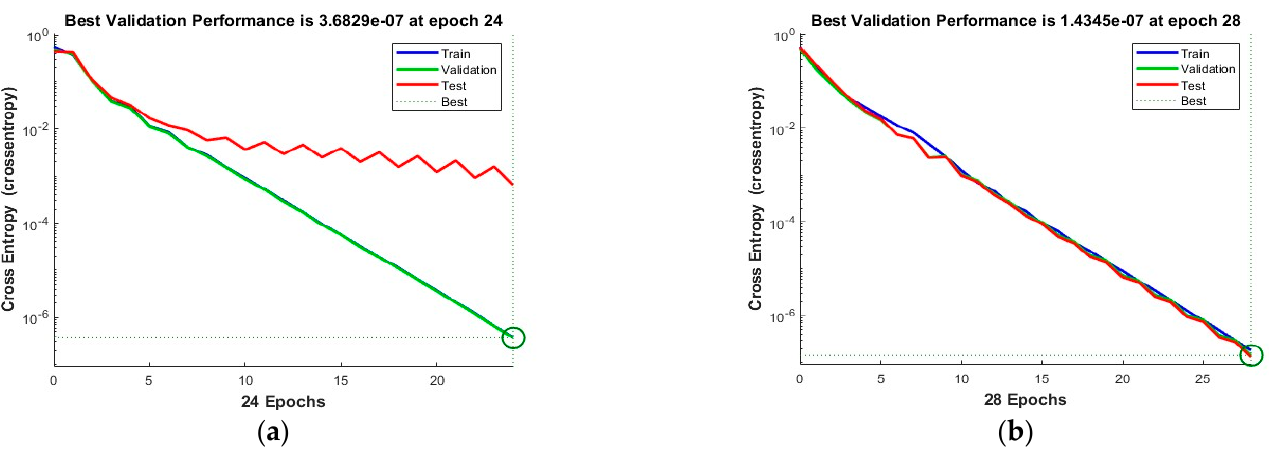
Figure 6. The convergence of the neural network for Dataset-1. ( a ) 10 Neurons and ( b ) 50 Neurons in the hidden layers.